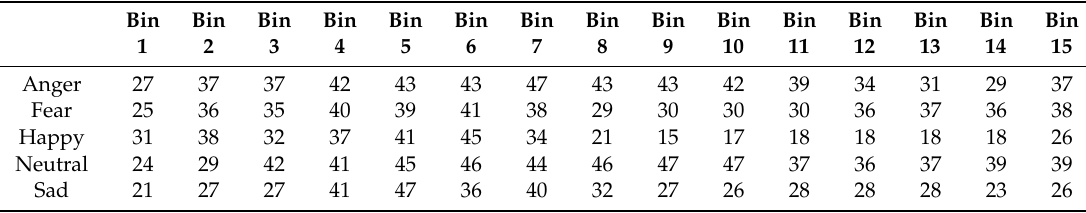
Table A3. Number of infants with ≥ 1 eye fixations per bin.